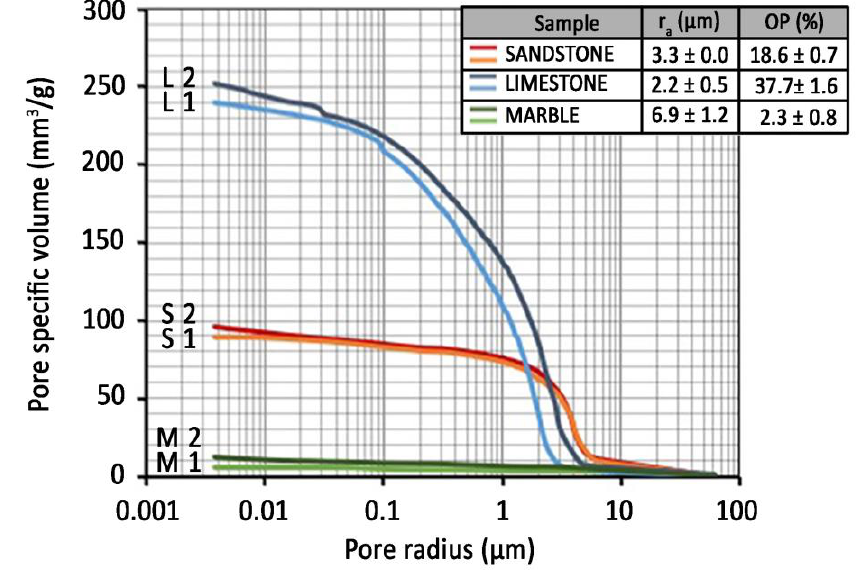
Figure 2. Pore size distribution curves of two samples of sandstone, limestone and marble, obtained by MIP. Open porosity ( OP ) and average pore radius ( r a ) in the table were averaged for two samples (L1 and L2 indicate the two limestone samples, S1 and S2 the two sandstone samples, M1 and M2 the two marble samples).